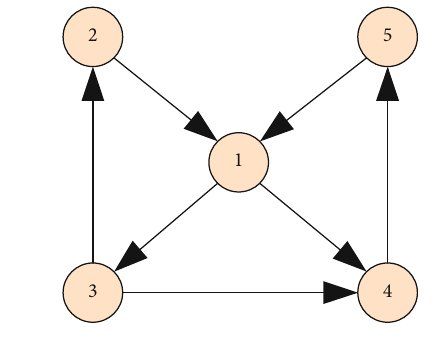
Figure 3: Interaction topology G